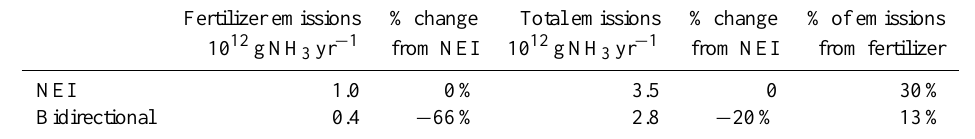
Table 1. Annual 2002 NEI and bidirectional NH 3 emissions estimated for the CONUS domain. Fertilizer emissions % change